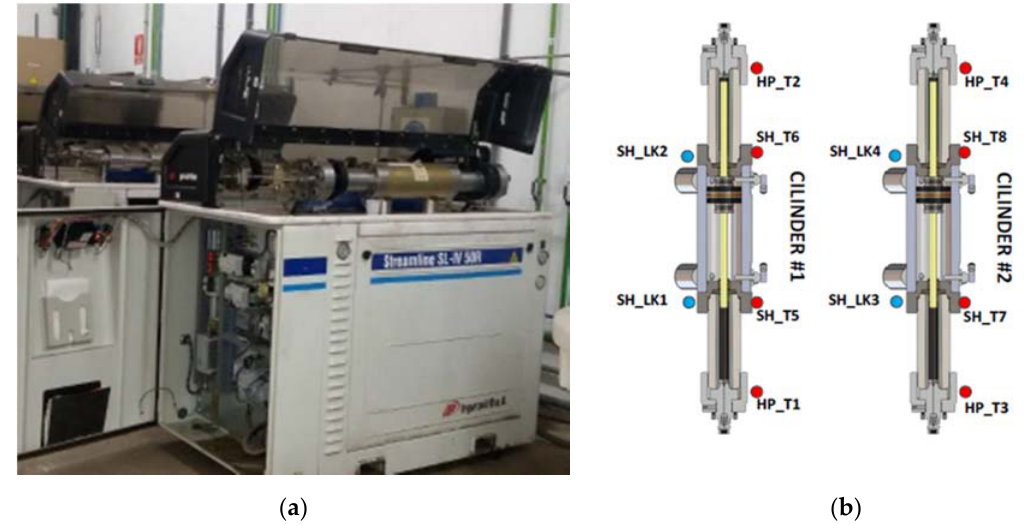
Figure 2. Example of intensifier and sketch of sensors (blue and red circles). ( a ) Picture of the intensifier. ( b ) Sensors placement sketch.